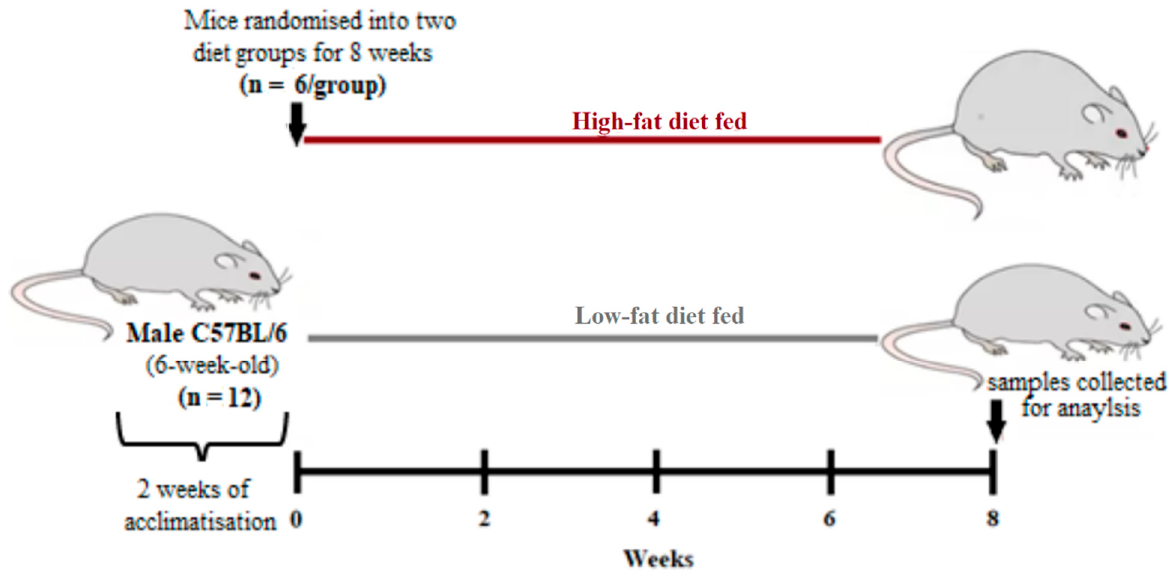
Figure 1. Experimental design. A total of 12 6-week-old male C57BL/6 mice were used in this experiment. Briefly, the mice were randomly allocated into two diets groups receiving a high-fat diet or a low-fat diet for 8 weeks ( n = 6/group). The weights were measured weekly, while the postprandial glucose levels, hematological parameters, and blood lipid profiles were measured on the eighth week after diet feeding.